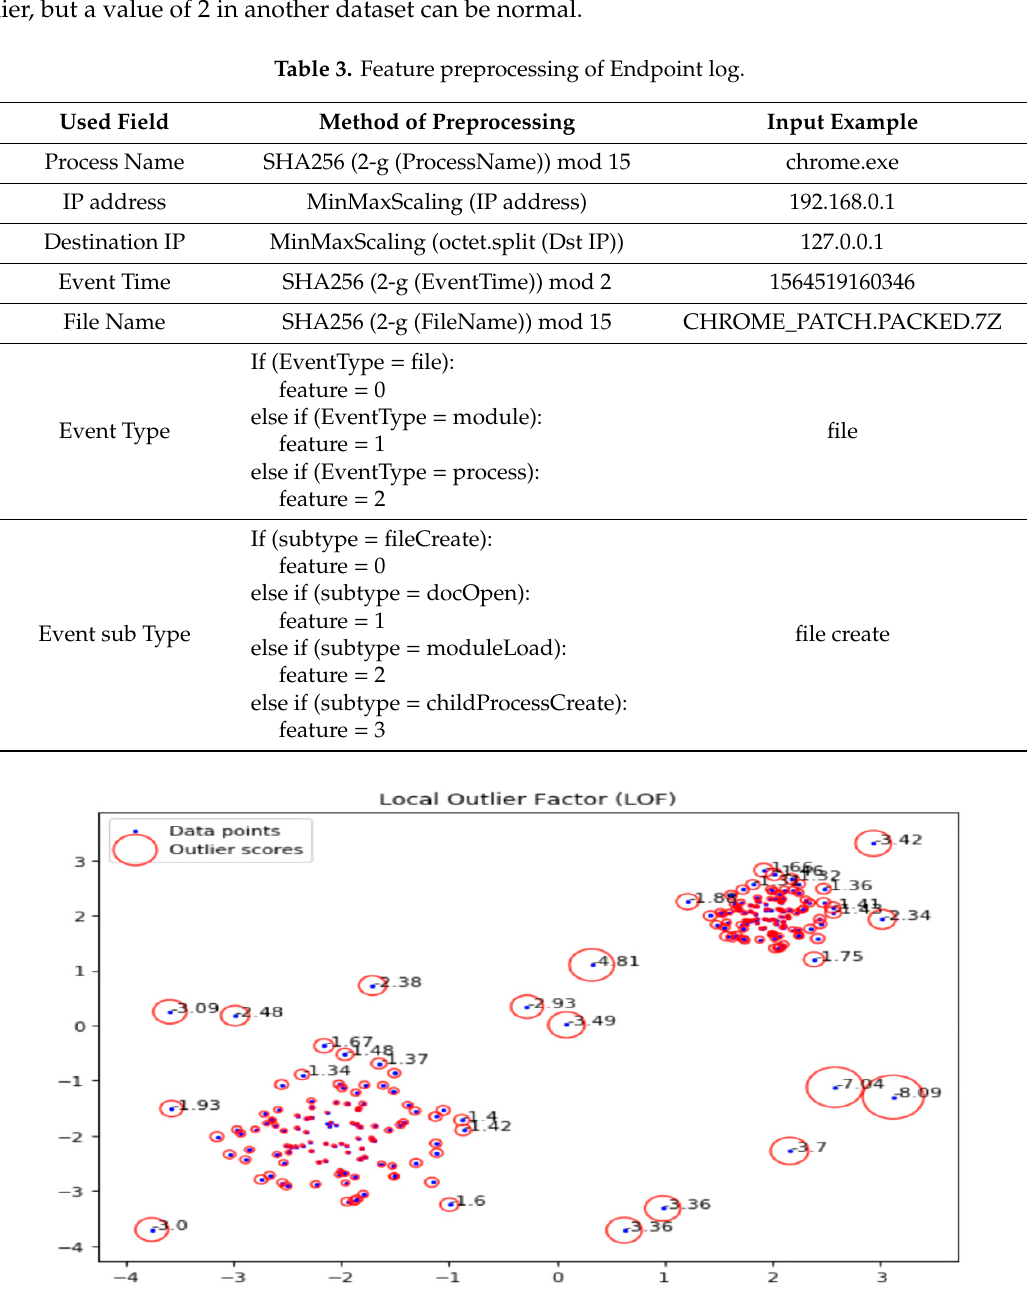
Figure 7. Cumulative distribution function example. 3.2.2. AutoEncoder Based Anomaly Detection Unsupervised learning-based AutoEncoder is used to calculate anomaly scores. AutoEncoder is simply a neural network that copies inputs to outputs. If the AutoEncoder model only trains normal events, it uses the fact that the loss values are large when predicting abnormal data [28,29]. The extracted features are created by referring to a single event rule that can cause threat. However, the system behavior model and network behavior model were independently generated for accurate model learning. The process path and event time apply equally to both network behavior and system behavior features. Features using the process path are extracted by applying feature hashing to the string. The event time is based on the day of the week and the time it occurred. In the network behavior feature, there was a destination IP address field that we tried to access, and the entire feature hashing was performed. To add the suspicious local IP address of the destination IP address, the min–max scaling was applied using only the A and B classes. For the system behavior feature, feature